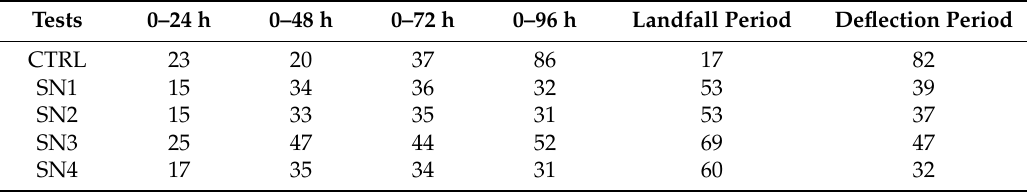
Table 3. Mean track errors in the first 24, 48, 72, 96 h and during different periods (units: